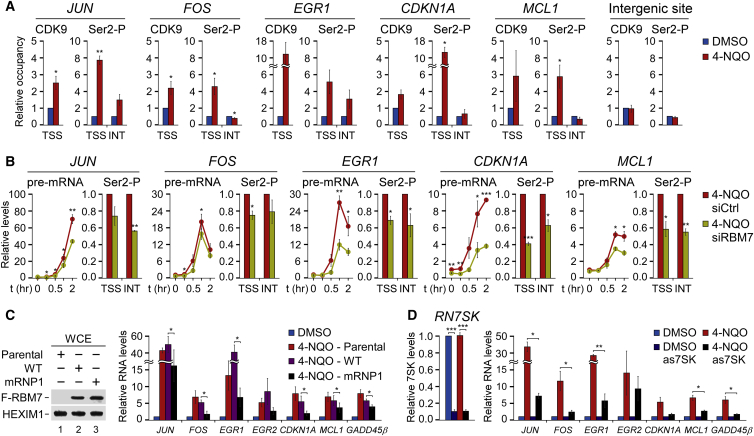
RBM7 and 7SK snRNP Are Critical for the Induction of P-TEFb-Dependent DDR Genes(A) ChIP-qPCR of the occupancy of CDK9 and Ser2-P relative to Pol II at transcription start site (TSS) and in the middle of gene interior (INT) of the indicated DDR genes. The ChIP-qPCR data at the intergenic site ∼100 kb upstream of FOS TSS is also presented. Conditions with (red bars) and without (blue bars) 4-NQO are shown. Results were normalized to the DMSO control and are presented as the mean ± SEM (n = 3). ∗p < 0.05; ∗∗p < 0.01, determined by Student’s t test.(B) RT-qPCR (left) of unspliced transcripts (pre-mRNA) of the indicated DDR genes and ChIP-qPCR (right) of the levels of Ser2-P relative to Pol II at the TSS and in the middle of gene interior (INT) of the indicated DDR genes in control (siCtrl; red) and RBM7 knockdown (siRBM7 #2; yellow) 4-NQO-treated HeLa cells. In RT-qPCR assays, the cells were exposed to 4-NQO for 15 min, 0.5 h, 1 h, and 2 h as indicated, and results were normalized to the untreated control and are presented as the mean ± SEM (n = 3). ∗p < 0.05; ∗∗p < 0.01; ∗∗∗p < 0.001, determined by Student’s t test. ChIP-qPCR results were normalized to the control values that were set to 1 and are presented as the mean ± SEM (n = 3). ∗p < 0.05; ∗∗p < 0.01, determined by Student’s t test.(C and D) RT-qPCR of unspliced transcripts of the indicated DDR genes in parental, wild-type, and mRNP1 F-RBM7-expressing (C) or 7SK-depleted (D) HeLa cells. The cells were treated for 2 h with DMSO or 4-NQO as indicated by the legend. Results were normalized to the respective DMSO control and are presented as the mean ± SEM (C: n = 4; D: n = 3). ∗p < 0.05; ∗∗p < 0.01; ∗∗∗p < 0.001, determined by Student’s t test. Levels of the F-RBM7 proteins and efficacy of the RN7SK knockdown with the 7SK antisense DNA oligonucleotide (as7SK) are shown on the left.See also Figure S5 and Table S4.